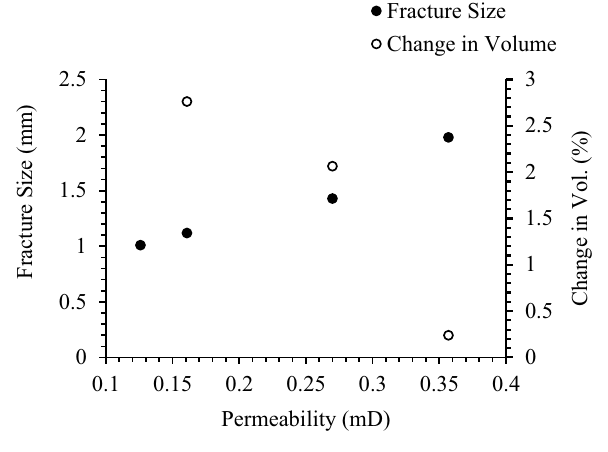
Fig. 16 Change in cleat spacing with pressure